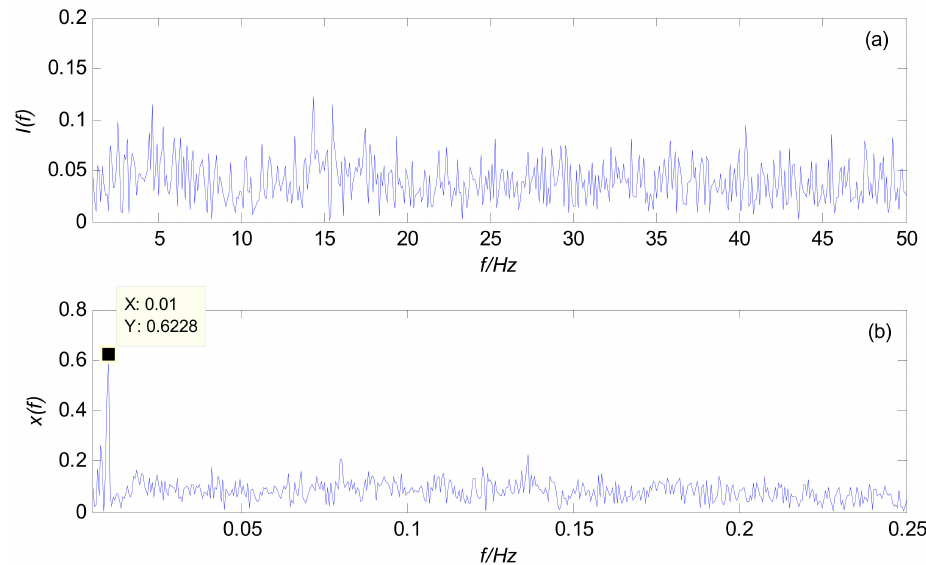
Figure 9. SR phenomenon of a field-drilling measured signal: ( a ) spectrum of the system input; ( b ) spectrum of the system output based on a variable scale.